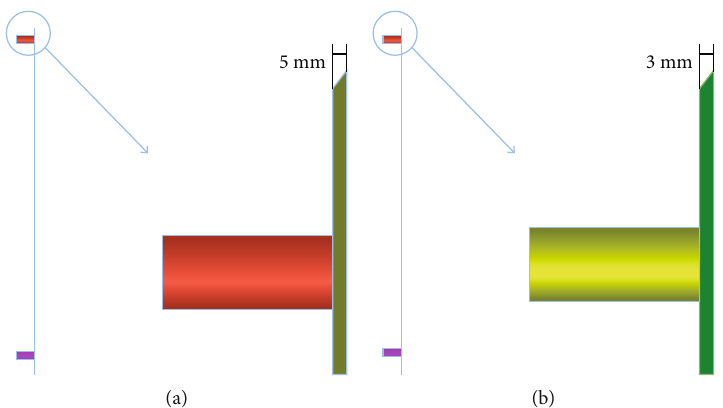
Figure 14: (a) 5 mm width fl ow channel and (b) 3 mm width fl ow channel.